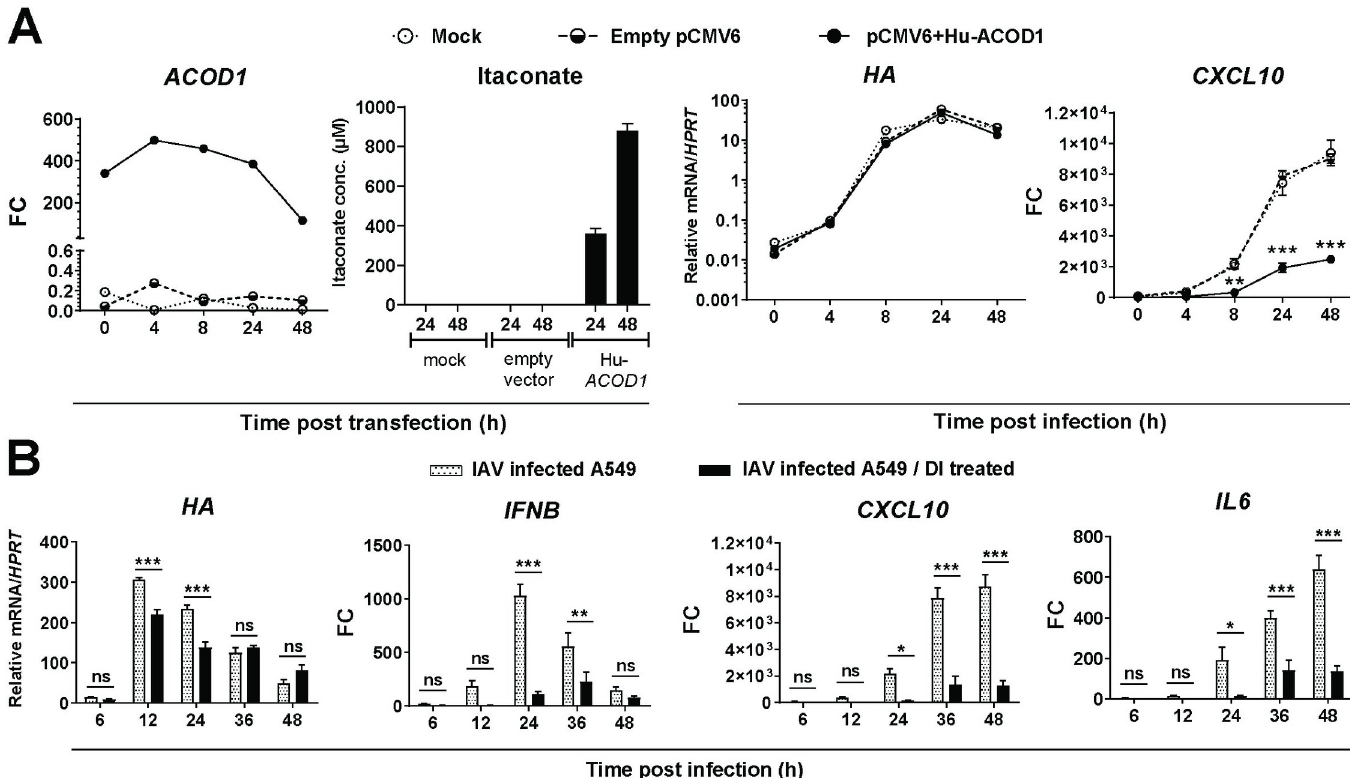
Fig 5. Effect of overexpression of ACOD1 and exogenous treatment with DI on IAV-infected A549 cells. A. A549 cells were transfected with pCMV6-Hu-ACOD1, pCMV6 empty vector, or mock transfected for 48 h and then infected with IAV (PR8M, MOI = 1) for 48 h (n = 3). Expression of the indicated mRNAs was measured by RT-qPCR, itaconate concentrations by LC-MS/MS. � p < 0.05; �� p < 0.01; ��� p < 0.001 (2-way ANOVA, Tukey’s multiple comparisons test) B. A549 cells were treated with 0.25 mM DI overnight, infected with IAV for 48 h (n = 3), and expression of the indicated mRNAs measured by RT-qPCR. Dose response curves of the effects of various concentrations of itaconate and DI on cell viability (MTT assay) are shown in S2 Fig . Reference for fold change = uninfected, untreated cells at the same time point. Mean ± SEM (n = 3). � p < 0.05; �� p < 0.01; ��� p < 0.001 (2-way ANOVA, Sidak’s multiple comparisons